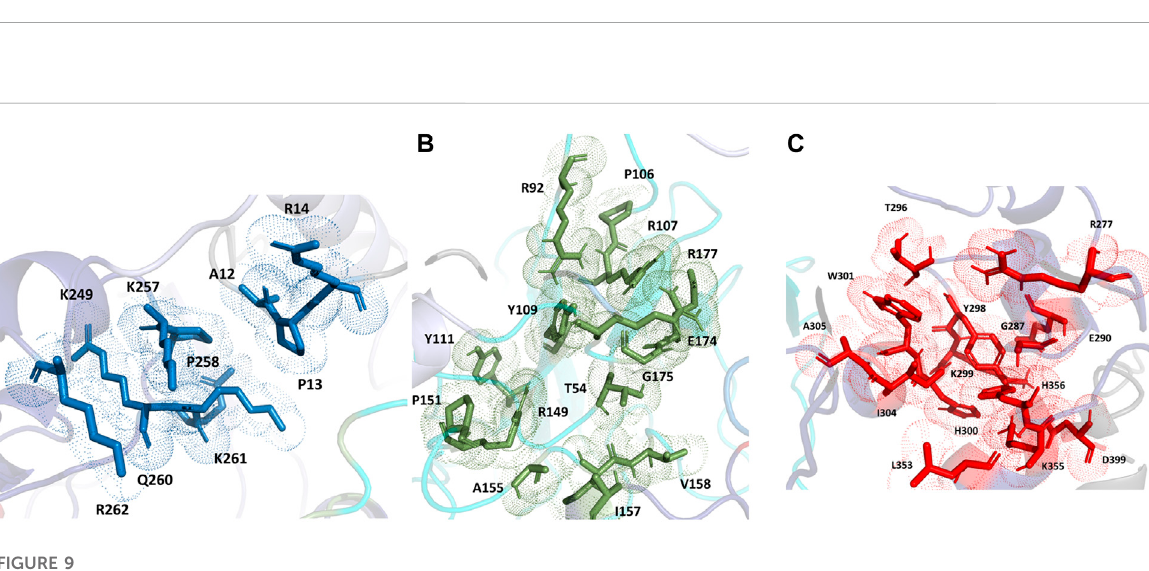
protein dimerization and oligomerization (Luo et al., 2006; Yu et al., 2006; Chen et al., 2007; Takeda et al., 2008). Some important residues domain are F66, R68, G69, Y123, I131, W132, V133, and A134 (Tatar et al., 2021).